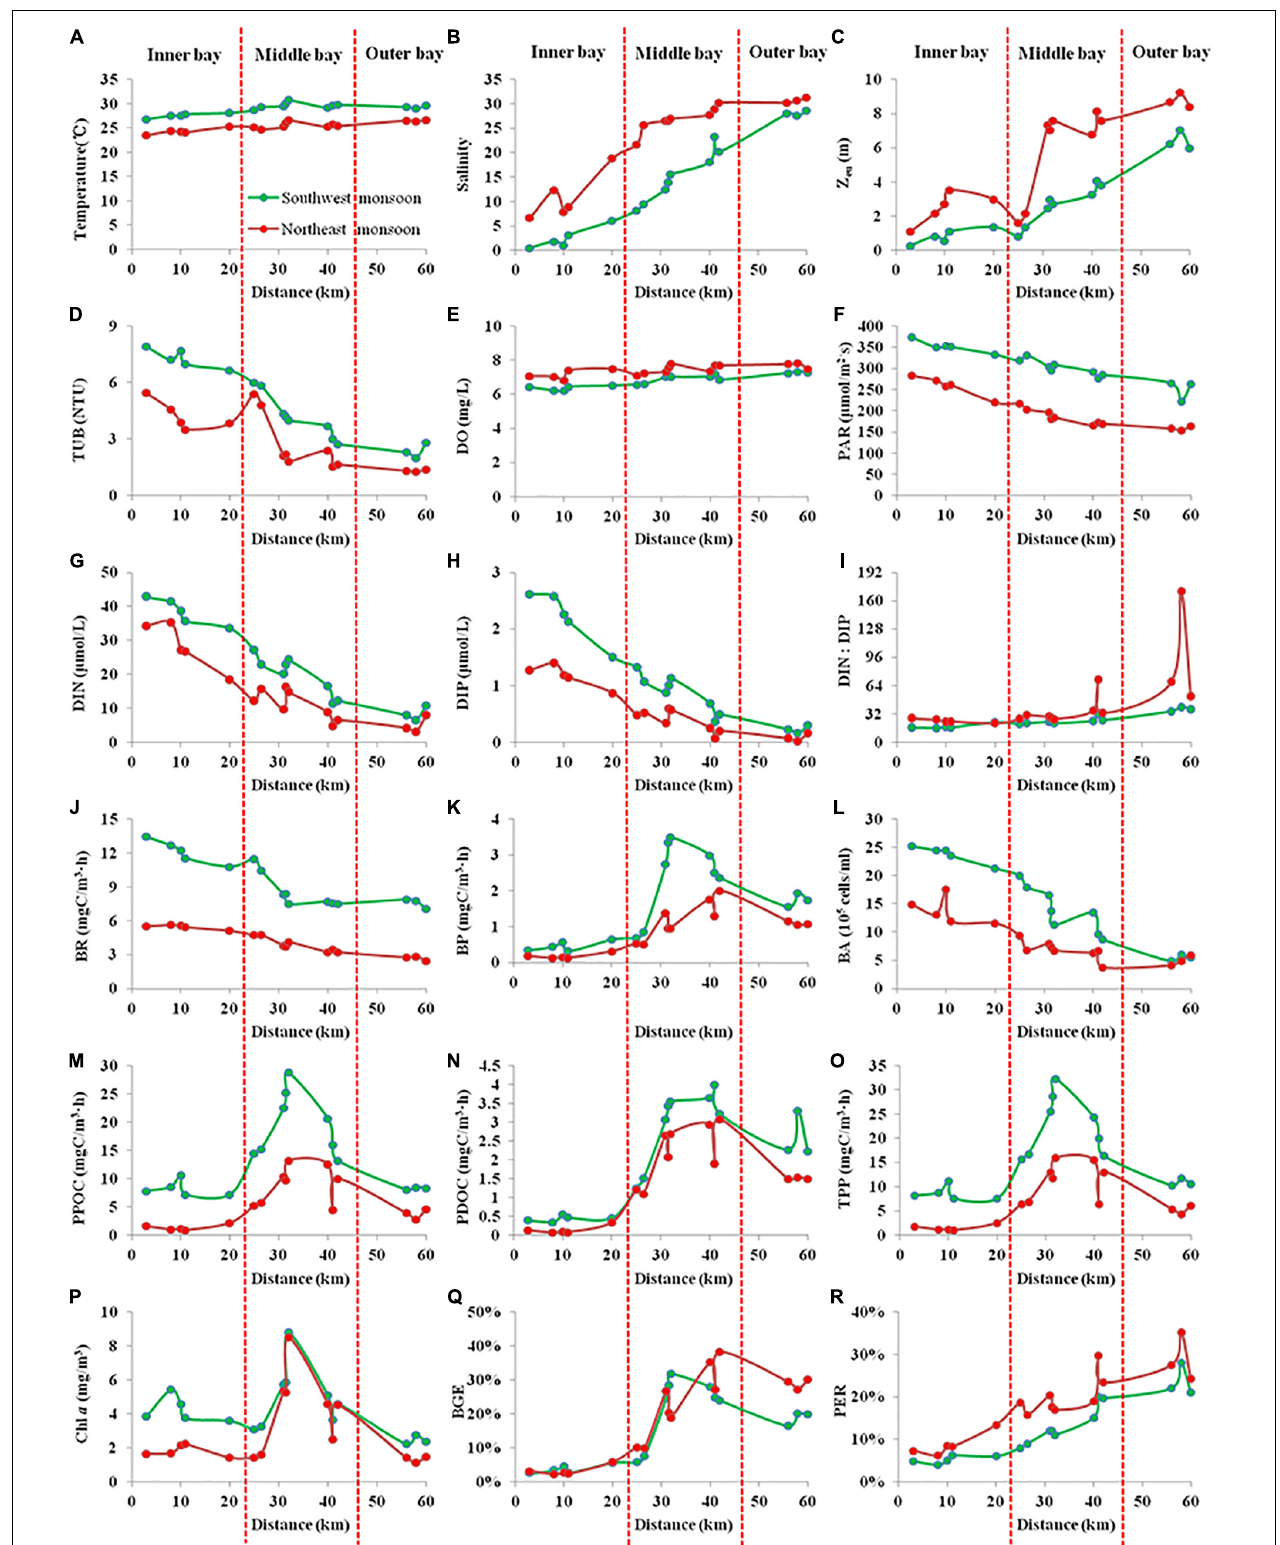
FIGURE 3 | The integral mean value within the euphotic depth (Zeu) of biogeochemical parameters [ (A) Temperature, (B) Salinity, (C) Zeu, (D) TUB, (E) DO, (F) PAR, (G) DIN, (H) DIP, (I) DIN:DIP, (J) BR, (K) BP, (L) BA, (M) PPOC, (N) PDOC, (O) TPP, (P) Chl a, (Q) BGE, and (R) PER] during SW and NE monsoon in the Qinzhou Bay (The X-axis refers to the distance of the site from the mouth of the western branch of Qinjiang river).